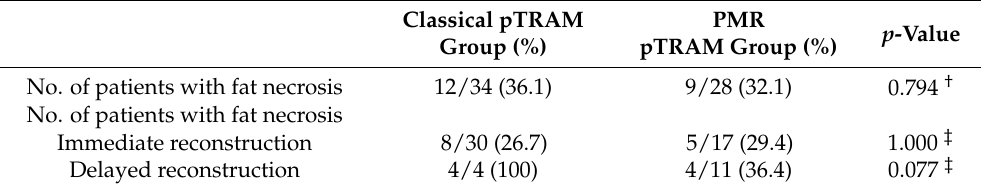
Table 3. Fat necrosis rate and relationship between classical and partial muscle resection pTRAM